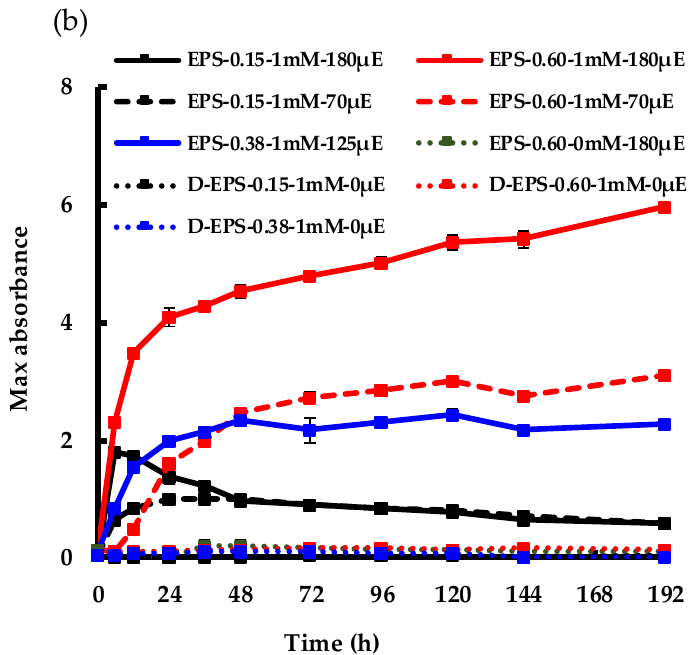
Figure 5. AgNP synthesis at different light intensities and EPS concentrations: ( a ) spectrophotometric measurements at 192 h; ( b ) change of SPR intensity vs. time over 192 h.